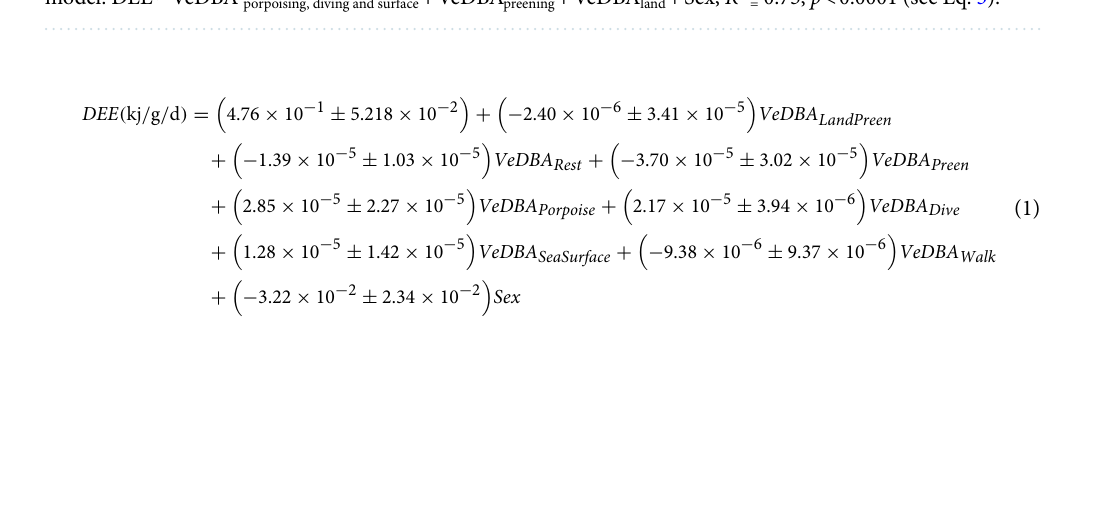
Figure 2. Daily VeDBA for porpoising, diving and surface periods predicts energy expenditure. Raw data points and regression relationship for the significant term in the top model (VeDBA porpoising, diving and surface ). Full model: DEE ~ VeDBA porpoising, diving and surface + VeDBA preening + VeDBA land + Sex, R 2 = 0.75, p < 0.0001 (see Eq.